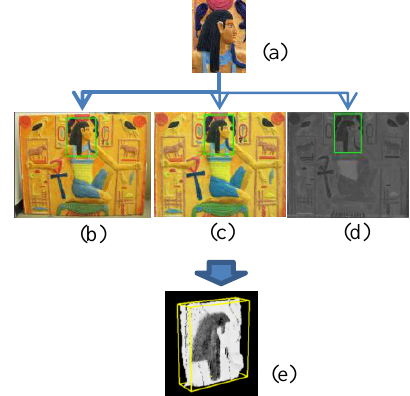
Figure 7. Point clouds corresponding to local images a) Local image, b) Global image, c) RGB point cloud image, d) Ppoint cloud gray image, e) Bureau local image corresponding point cloud region